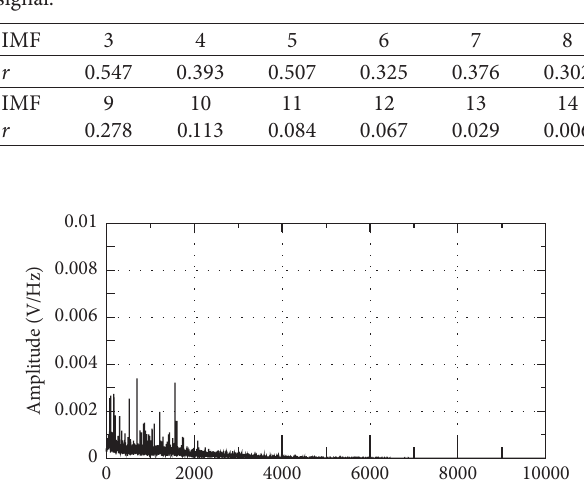
Figure 16: Frequency spectrum diagrams of each component after EEMD decomposition. (a) IMFs 1–7. (b) IMFs 8–14. Table 3: Correlation coefficient of each component and original signal.